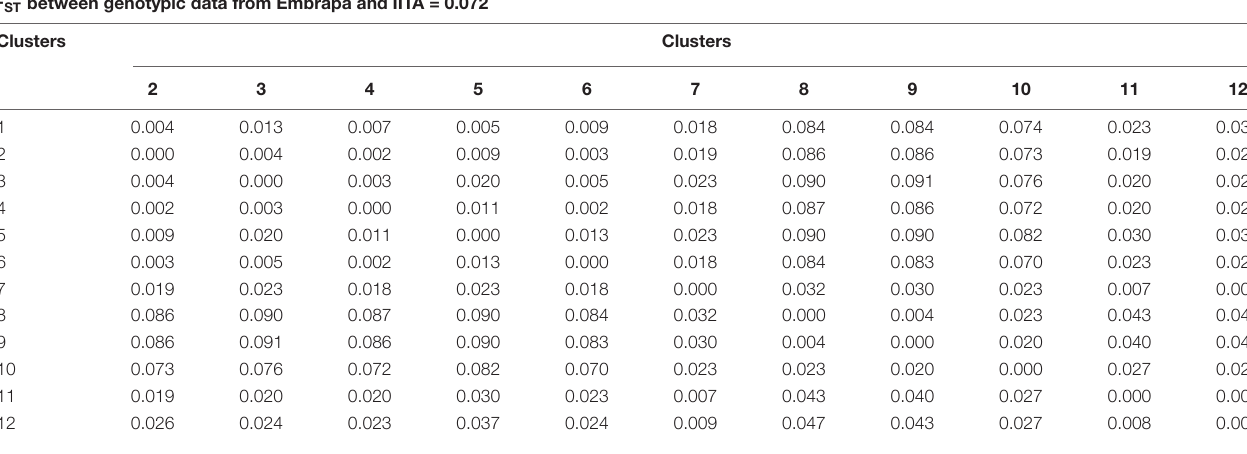
TABLE 4 | Fixation index (F ST ) estimated by single nucleotide polymorphisms (SNPs) between cassava clones from Embrapa and IITA and between clusters identified within the joint dataset (Embrapa + IITA). F ST between genotypic data from Embrapa and IITA = 0.072 Clusters